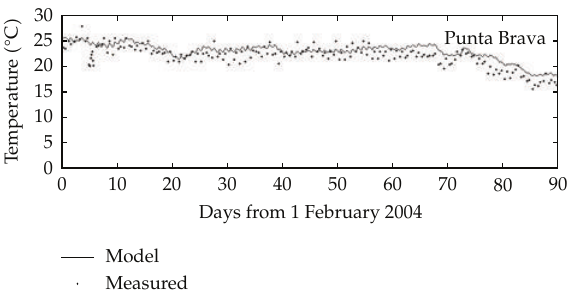
Figure 6: Comparison of the measured and modeled water temperature in Punta Brava station from February, March, and April 2004.